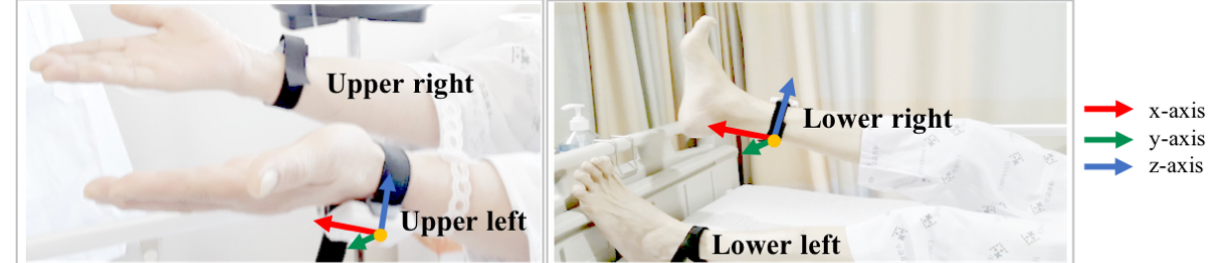
Figure 3. Schematic of upper and lower limb sensors and corresponding segment